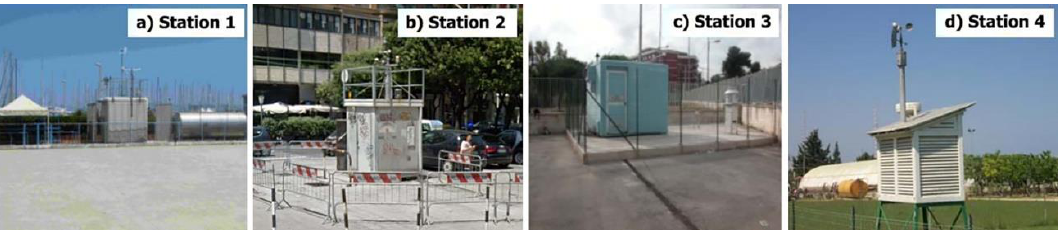
Figure 2. ( a ) Station 4 area, ( b ) station 1 area; ( c ) station 3 area; ( d ) station 2 area; ( e ) locations of the weather stations.